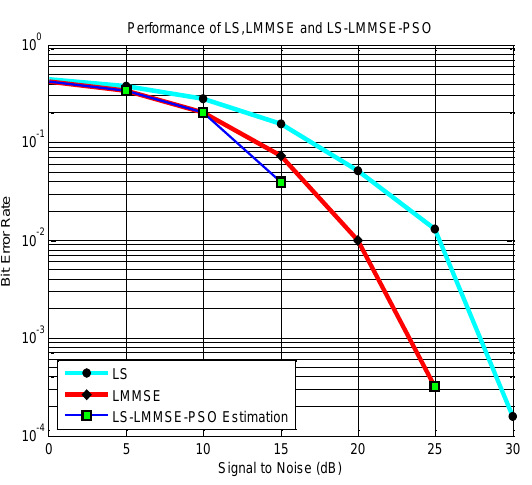
Figure 11: BER v/s SNR at Doppler frequency – 30